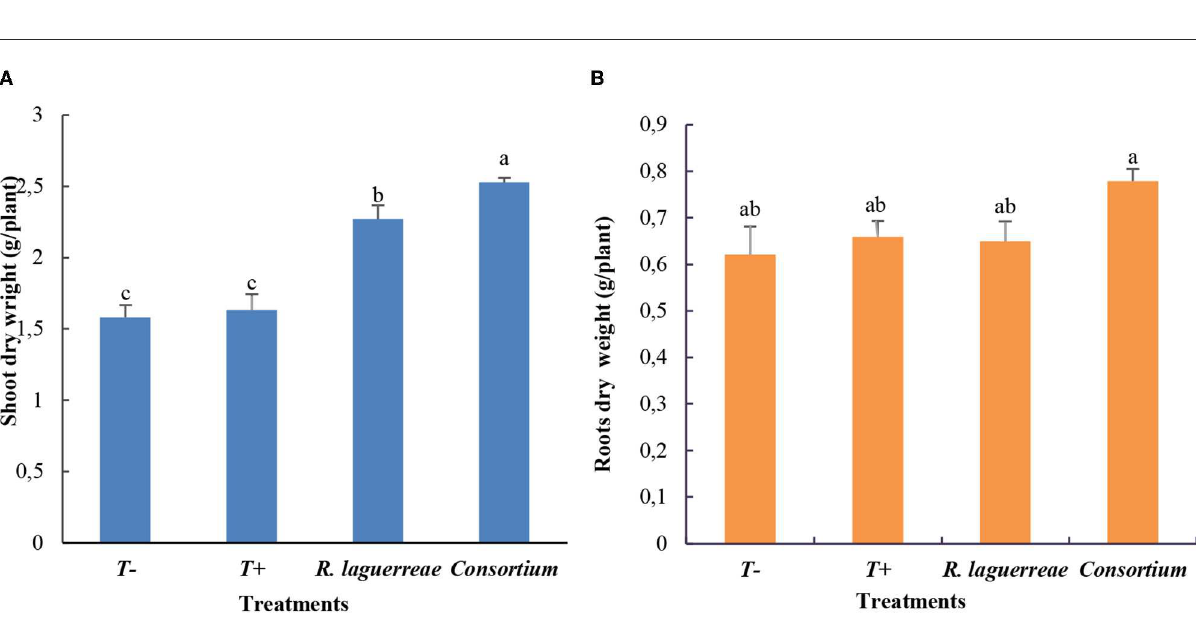
(15.38%) genera. The Siccibacter genus is a new phylum with some well-defined characteristics as described by Stephan et al.